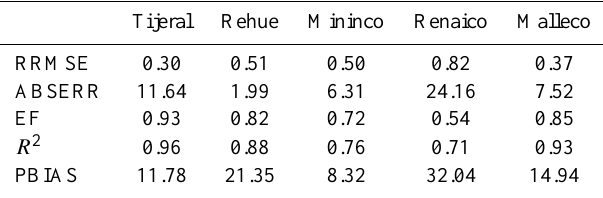
Table 8. RMS error, absolute error, efficiency, determination coef- ficient and percentage of Bias calculated for the period 2000–2002 after calibration.